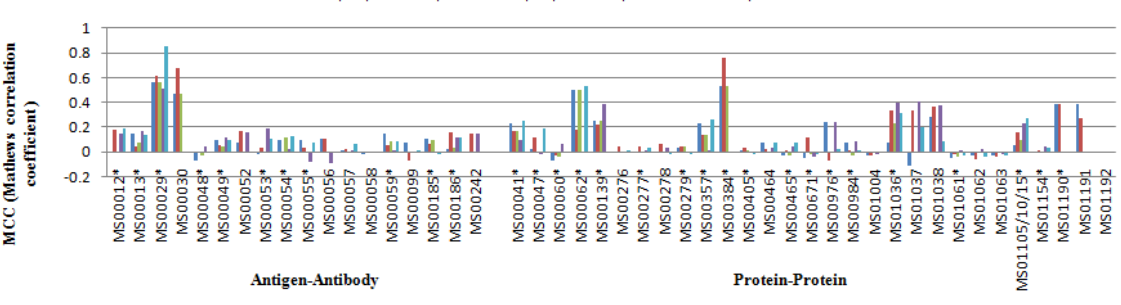
Figure 1. The MCC of each method on the benchmark dataset. The data which belong to the representative dataset were marked with